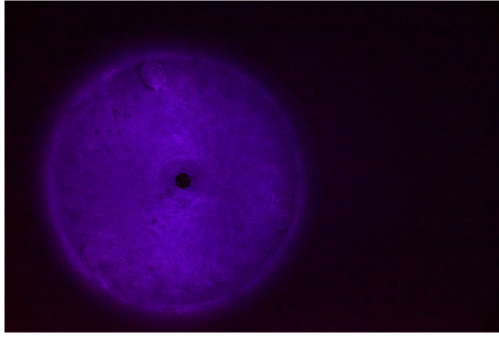
Figure 9. Baseline image.